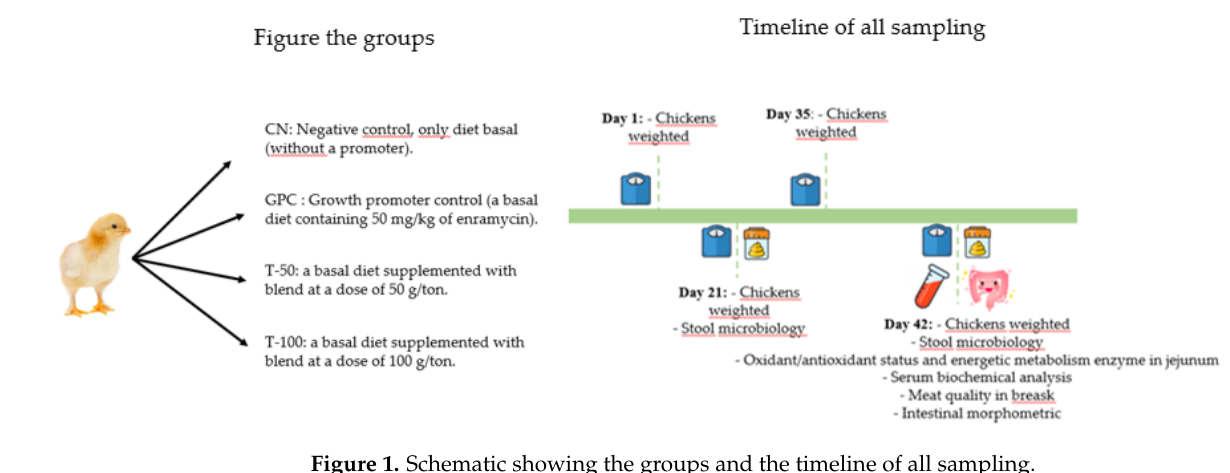
Figure 1. Schematic showing the groups and the timeline of all sampling.